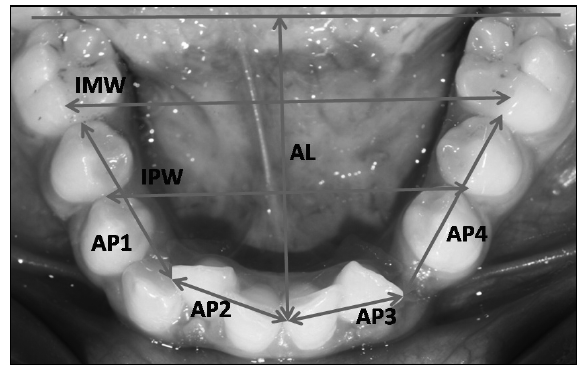
Figure 1. Measurements relating to the mandibular arch. IPW, Inter- premolar arch width; IMW, Inter-molar arch width; AL, Arch length; AP, Arch perimeter = sum of individual straight line approximations of the dental arch, i.e.